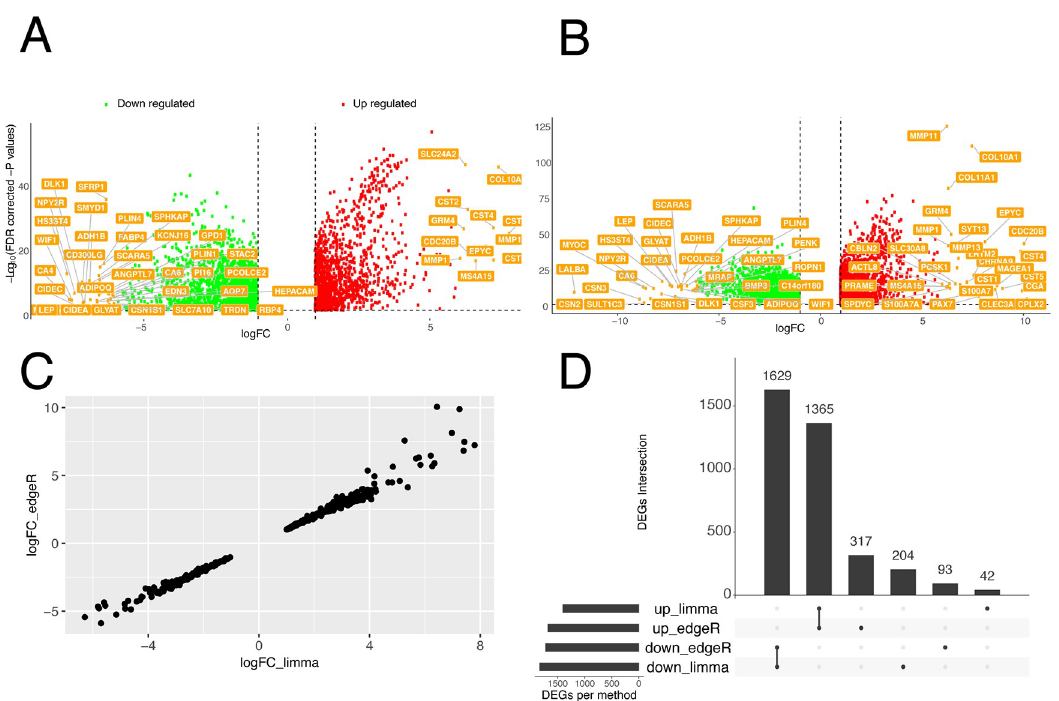
Fig 3. DEA analyses of TCGA-BRCA data comparing luminal subtypes with normal samples. A-B) Volcano plots are shown where only those genes with logFC higher than 6 or lower than -6 are labelled and only the significant up- or down-regulated genes are shown as dots. We carried out DEA using the limma (A) or edgeR pipelines (B) of TCGAbiolinks . C) The correlation plot between the logFC estimated by the two pipelines for the top 500 DE genes is shown. The genes discussed in the main text are highlighted in bold. D) The intersect between all the DE genes estimated by the two pipelines is shown using UpSet .